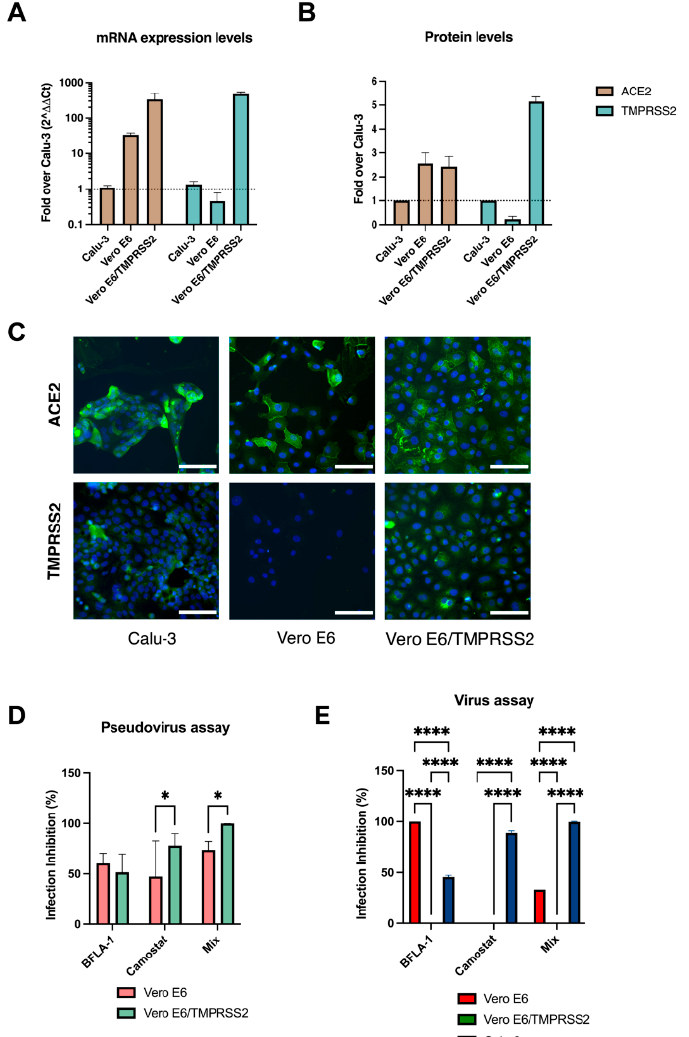
low sensitivity of the monoclonal antibodies in the experimental assay.